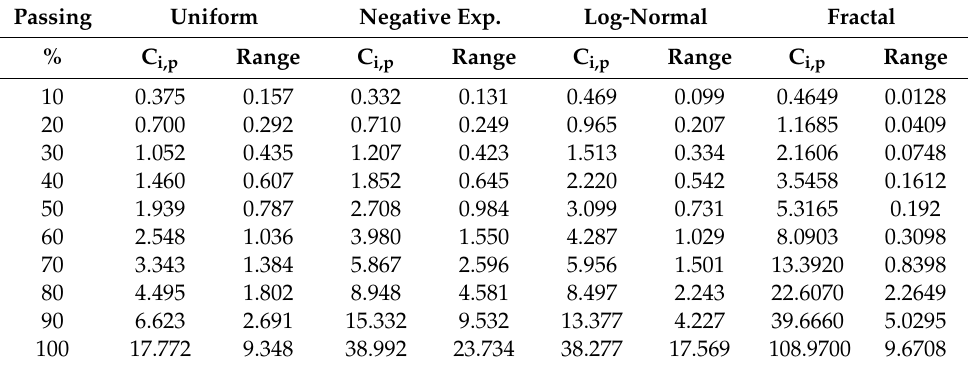
Table 1. Coe ffi cients C i,p with 90% confidence intervals for the relationship in Equation (2), considering di ff erent distributions of the product of principal mean spacing values of discontinuities (modified from